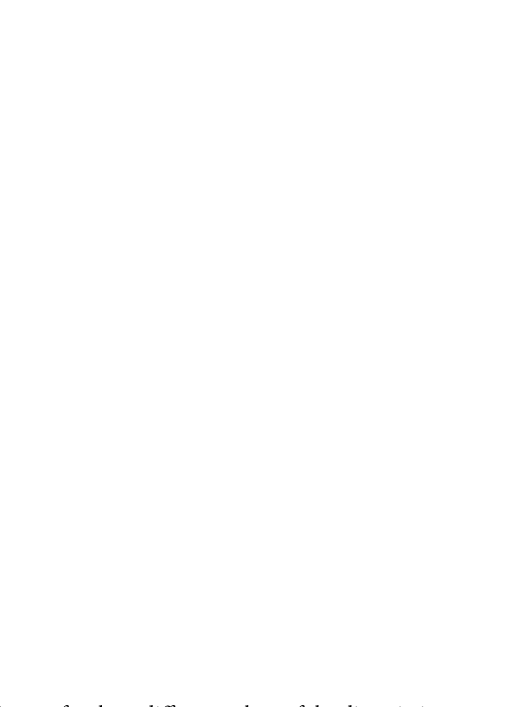
Table 1. Energy spectrum ( E n , ℓ ) for various n and ℓ states for three different values of the dissociation energy (cid:31) 0.20 and (cid:31) 0 0.25, r e 1, α with µ = = = = =